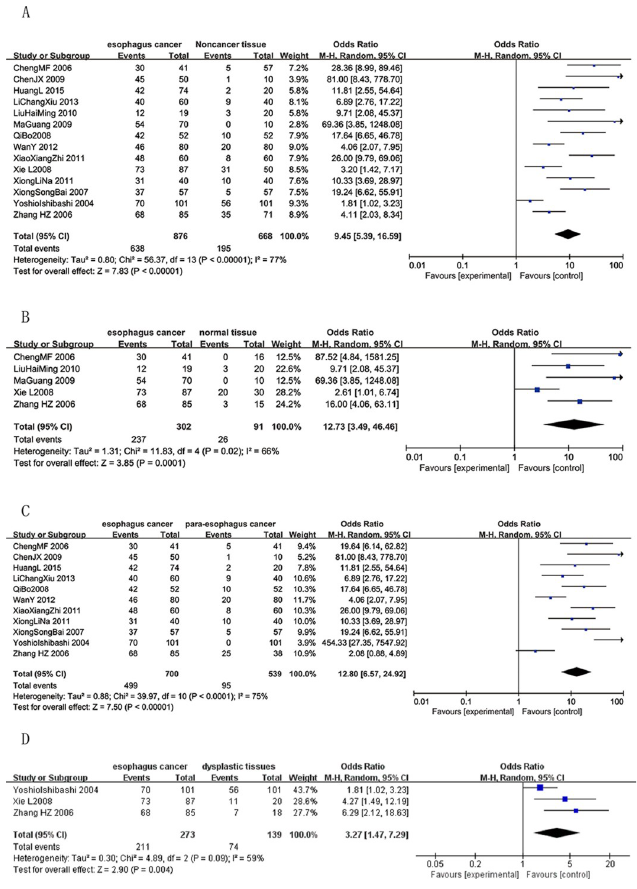
Fig 3. Forest plots of CD147 expression and different tissues. The squares and horizontal lines correspond to the study-specific OR and 95% CI. The area of the squares reflects the study-specific weight (inverse of the variance). The diamonds represent the pooled OR and 95% CI. The solid vertical line is at the null value (OR = 1). A CD147 positive expression between cancer and noncancer tissues. Significant difference was found between cancer and noncancer tissues (OR = 9.45,95%CI = (5.39,16.59), P < 0.00001). B CD147 positive expression between cancer and normal tissues. Significant difference was found between cancer and normal tissues (OR = 12.73, 95%CI = (3.49,46.46), P = 0.0001). C CD147 positive expression between cancer and para-carcinoma tissues. Significant difference was found between cancer and para-carcinoma tissues (OR = 12.80, 95%CI = (6.57,24.92), P < 0.00001). D CD147 positive expression between cancer and dysplastic tissues. Significant difference was found between cancer and dysplastic tissues (OR = 3.27, 95% CI = (1.47,7.29), P = 0.004).